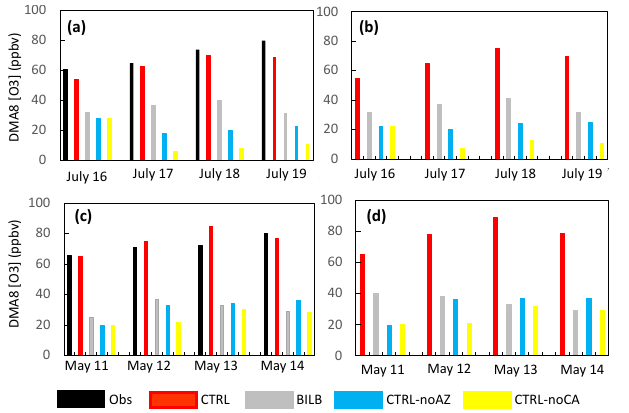
Figure 6. Mean DMA8 [O 3 ] in Phoenix metropolitan area from observation (Obs), simulation from CTRL runs (CTRL), BILB runs (BILB), and the relative contributions of different emission sources. CTRL-noAZ represents the modeled DMA8 [O 3 ] differences be- tween CTRL run and noAZ run. CTRL-noCA displays the modeled DMA8 [O 3 ] differences between CTRL run and noCA run. Obser- vation sites show in Fig. 1b. (a) DMA8 [O 3 ] at observation sites for 16–19 July 2005, (b) the same as (a) but for that averaged from Phoenix urban grid cells. (c) and (d) , the same as (a) and (b) but for the case of 11–14 May 2012.